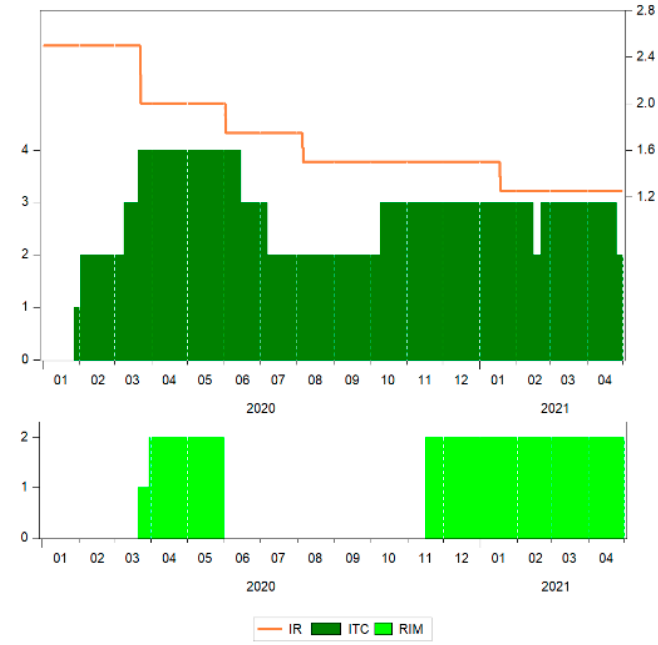
Figure 5. The response of national authorities in Romania in terms of the monetary policy interest rate (IR), international travel control (ITC) and internal movement restrictions (RIM). Source: authors’ contribution using EViews 10 software.